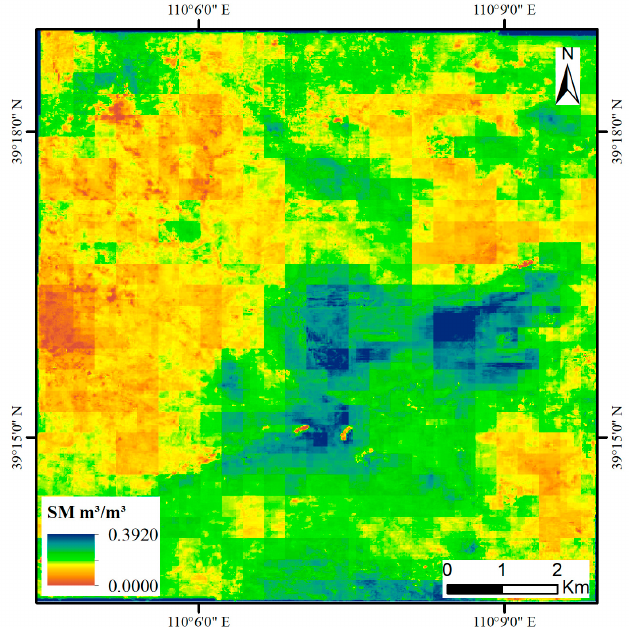
Figure 7. Spatial distribution of downscaled SM from 3 km SPL2SMAP_S in the study area using all auxiliary data.